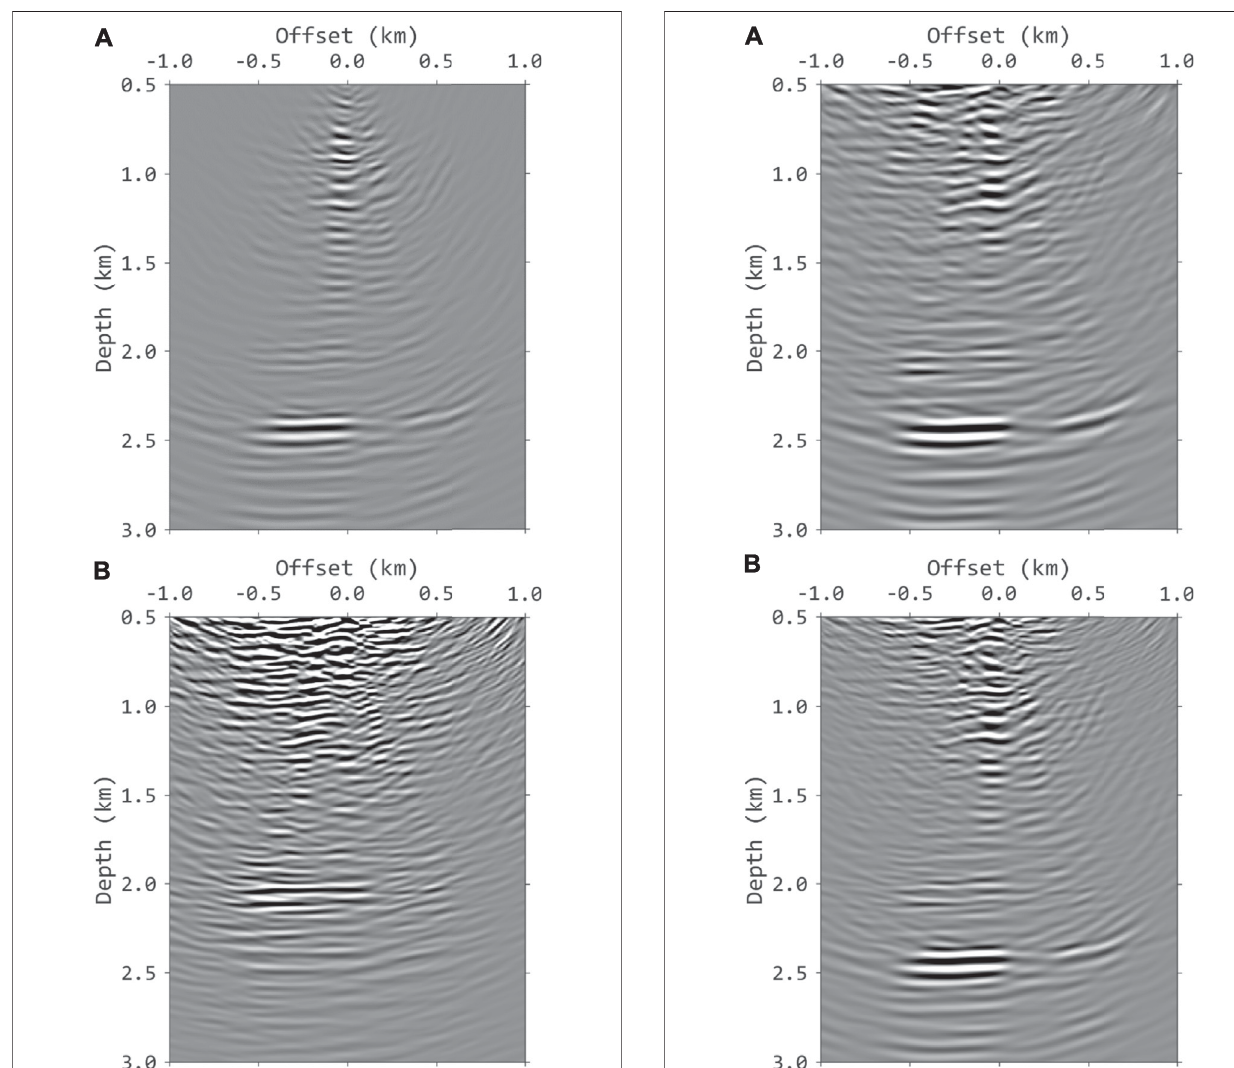
FIGURE 11 | Imaging results of the walkaway VSP fi eld data using inverse-scattering imaging condition with wave fi eld decomposition: (A) The image using primaries only. (B) The image using DDM. Compared to Panel 10 , the re fl ection amplitudes are well preserved, and the resolution is improved.